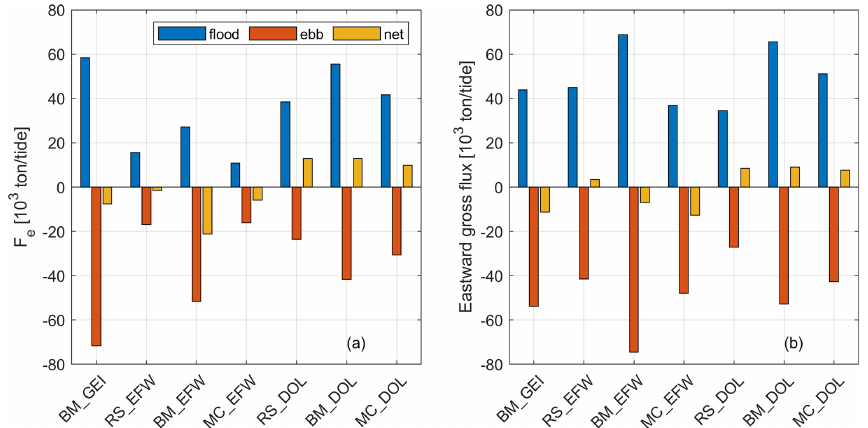
Figure 10. Gross and net flux F e (eastward positive), computed from one spring–neap cycle of observations at the long-term moorings in 2018 (a) and 2019 (b) .